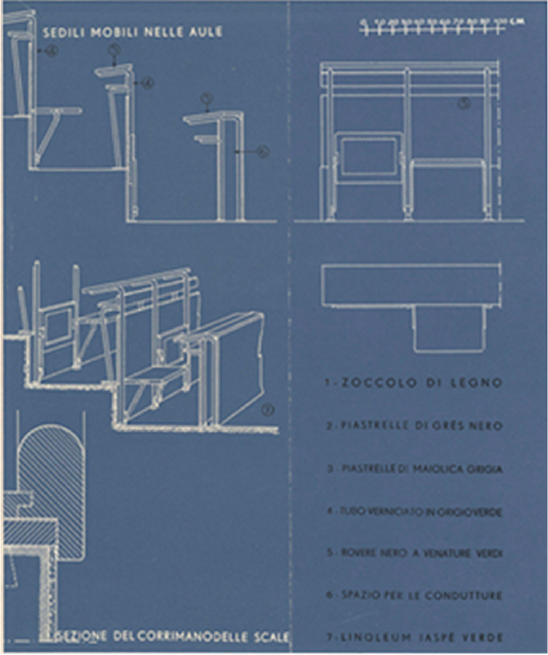
Figure 44. Technical drawing of articulated bench. Image from (De Smaele 1936, p. 20).